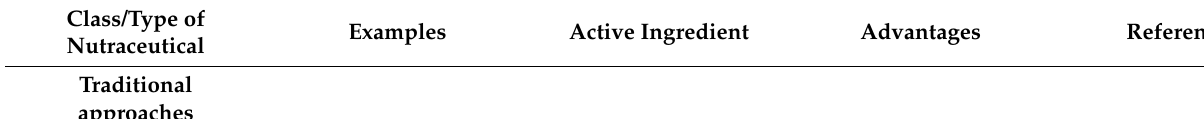
Table 1. Summary of types of nutraceuticals and their potential effects on